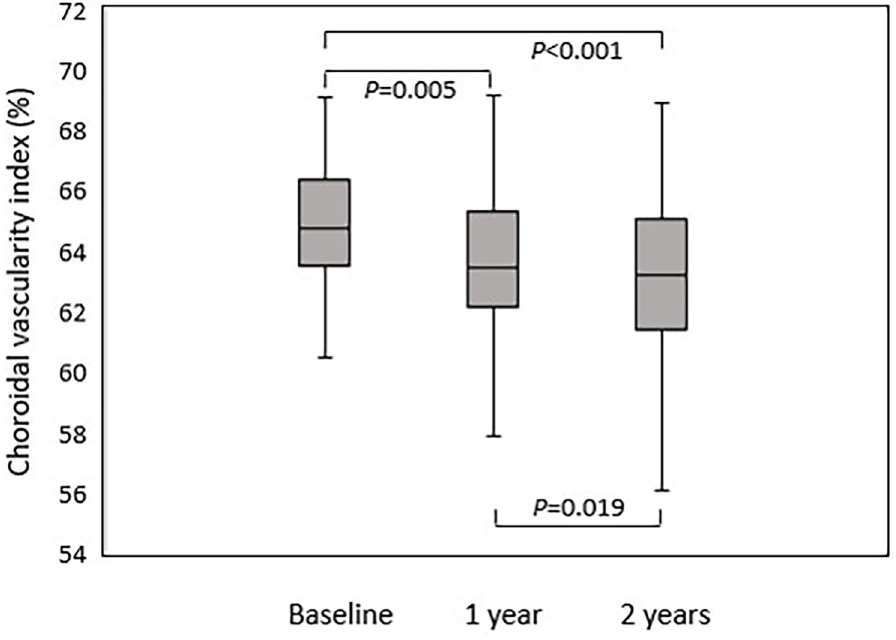
Fig 2. Choroidal vascularity index in MacTel group evaluated by repeated measures ANOVA tests and post hoc analysis. Reduction in choroidal vascularity index was statistically significant between baseline and 1 year( p = 0.005), 1 year and 2 years( p = 0.019), and baseline and 2 years( p <